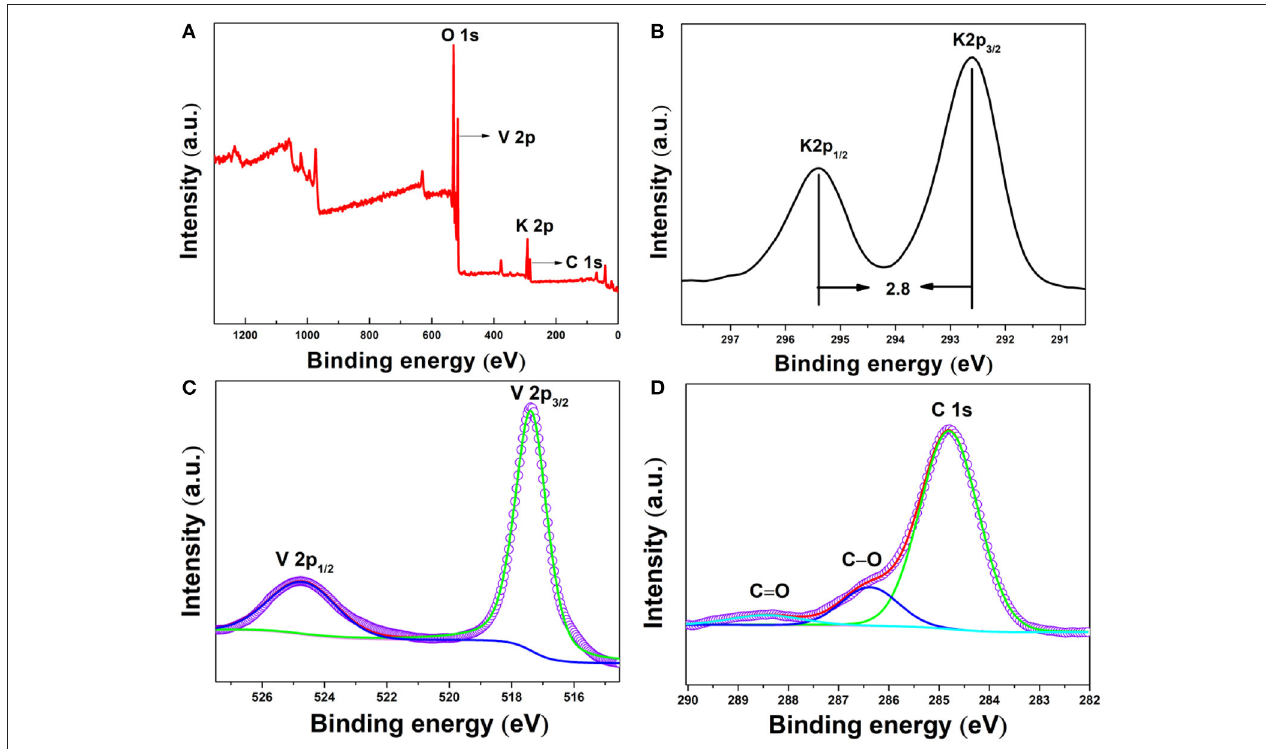
FIGURE 5 | XPS spectra for K 2 V 8 O 21 compound: (A) survey scan spectrum and high-resolution spectra of (B) K 2p, (C) V 2p and (D) C 1s.